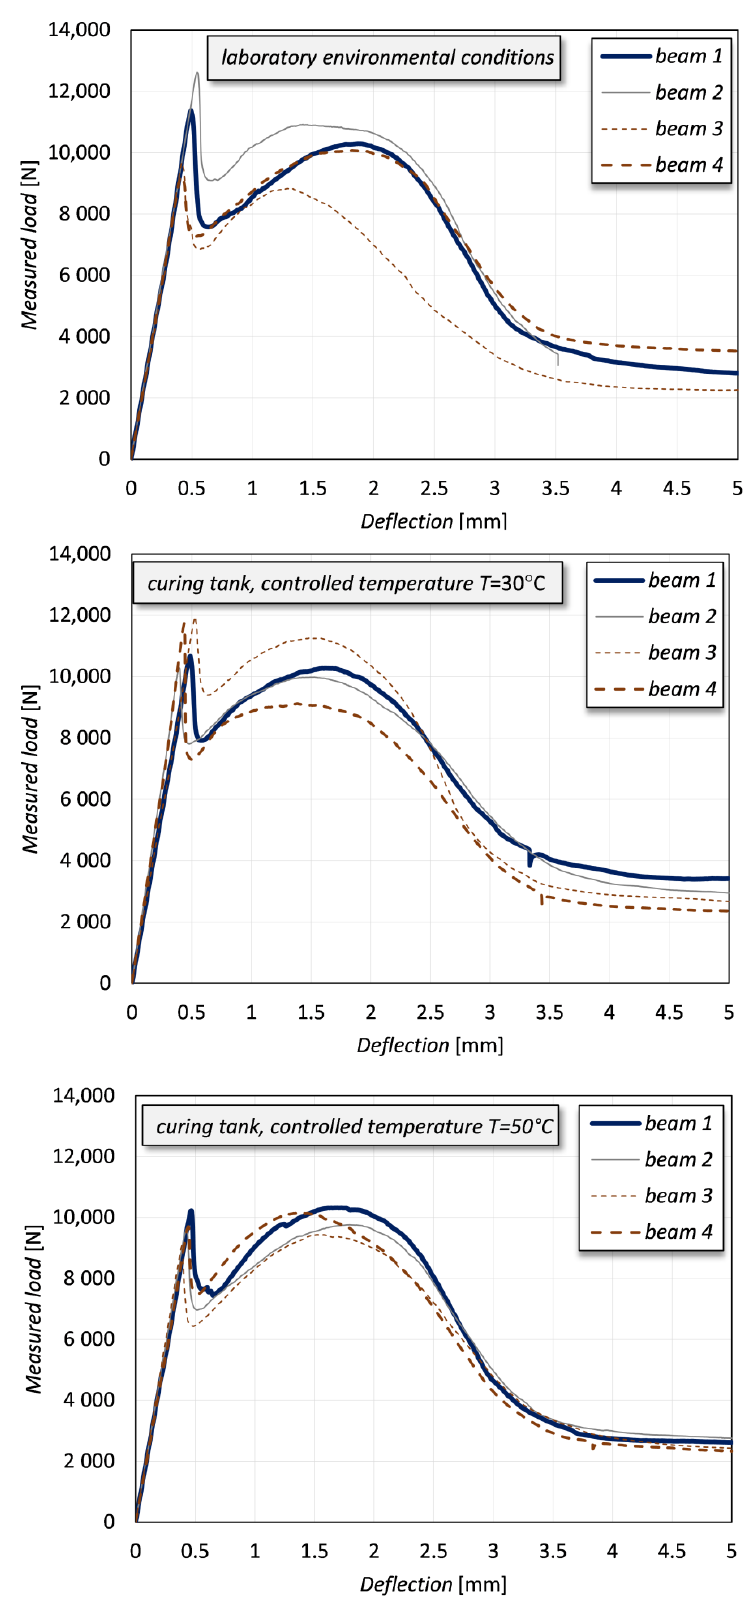
Figure 9. Results of the tests in terms of load-deflection curves for different curing